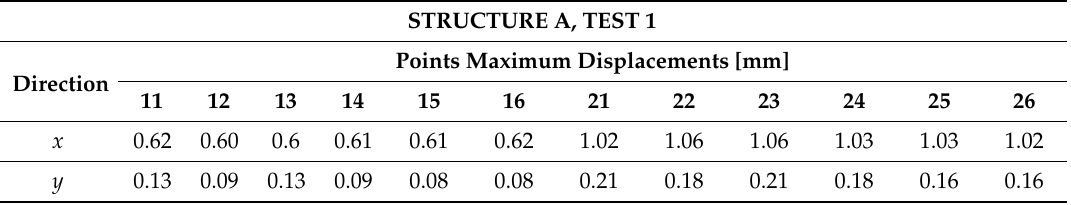
Table 10. Maximum displacements [mm] for each point, seismic action 2, combination (100% x , 30% y